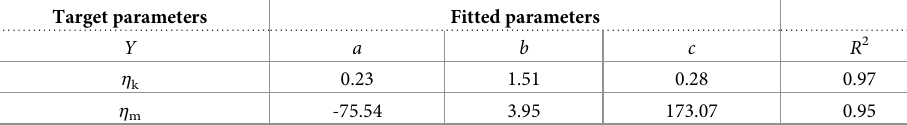
Table 5. Fitted parameters of viscosity coefficient of mudstone.